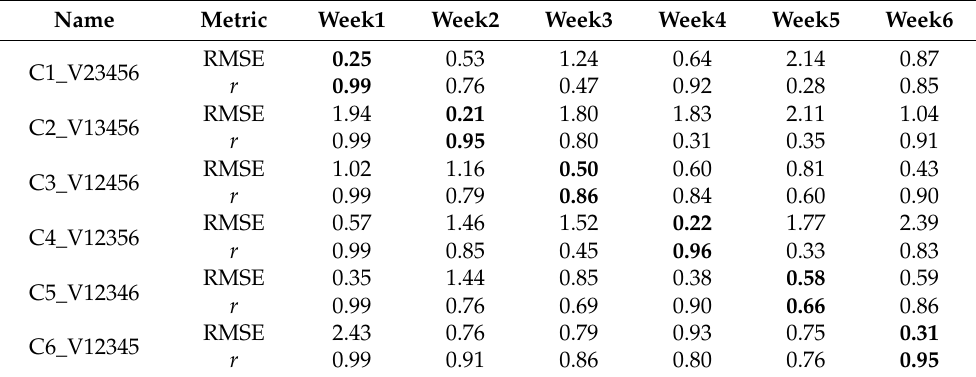
Table 4. Accuracy of models calibrated on one week of data. The values in bold indicate the accuracy of the training week. The corresponding line plots for these bold values are in Figure 5.